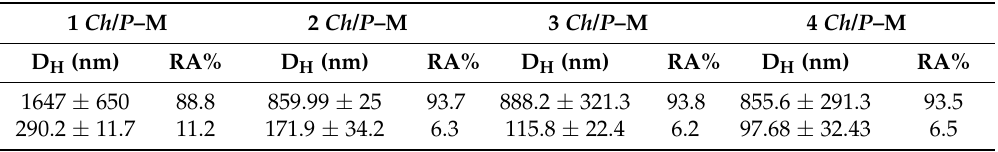
Table 4. Values of the hydrodynamic diameter D H and the relative amount (RA (%)) as obtained by DLS for chitosans/Phospholipids–Mucin ( Ch / P